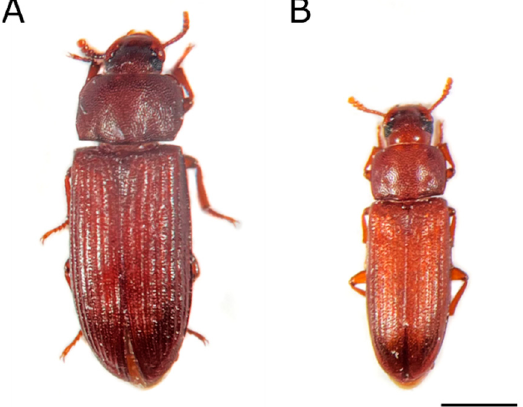
Figure 1. Dorsal view of the Kashmir flour beetle Tribolium freemani ( A ) and the red flour beetle Tribolium castaneum ( B ). Scale bar = 1 mm.